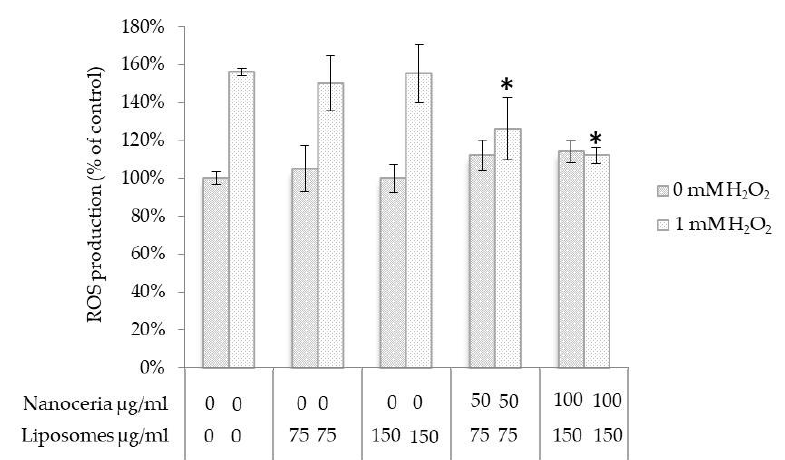
Figure 3. Quantitative evaluation of reactive oxygen species levels in NHDF cells treated with empty liposomes and nanoceria ‐ loaded liposomes, with and without H 2 O 2 pro ‐ oxidant insult; * p < 0.05.